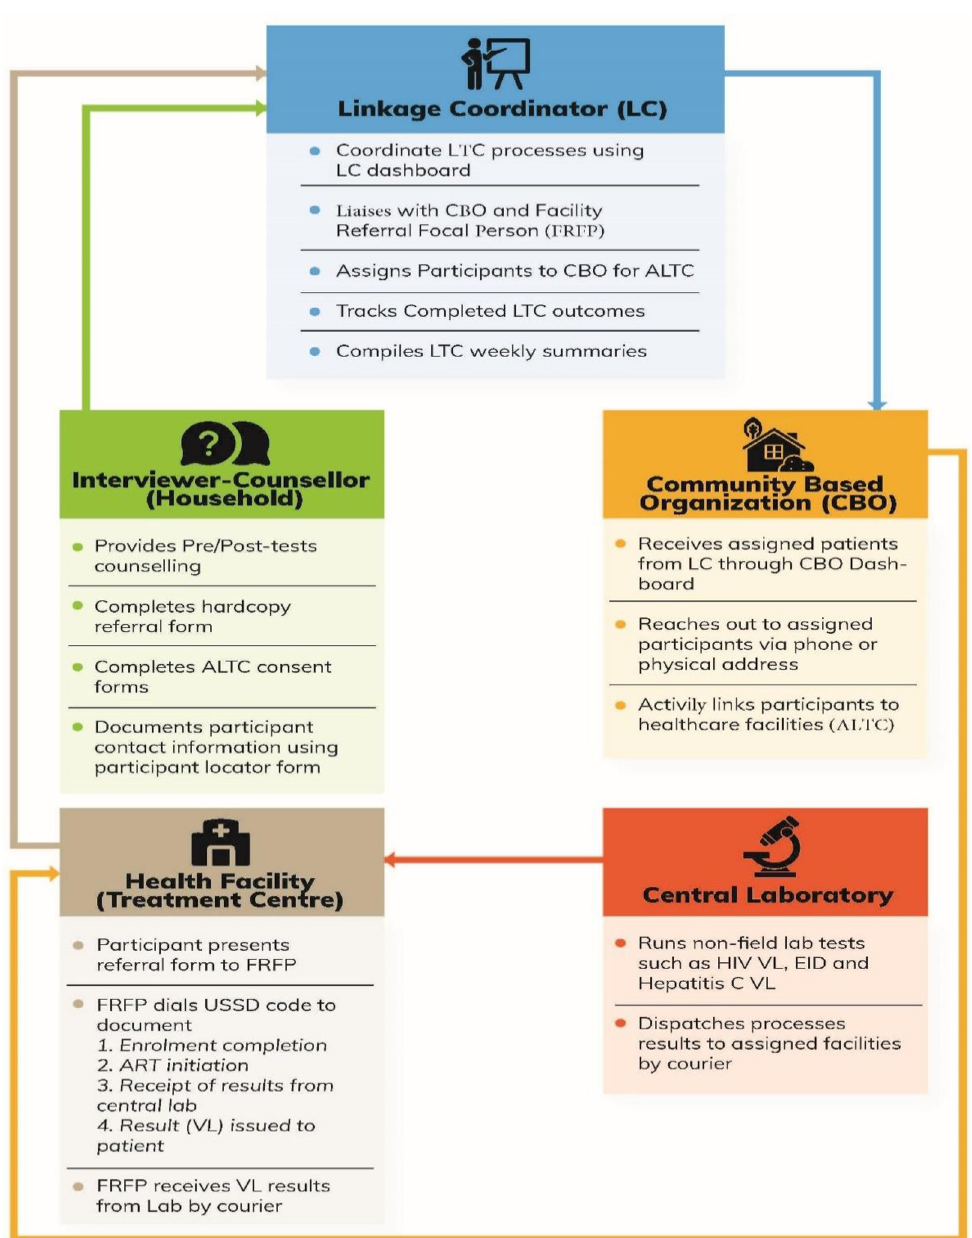
Fig 1. Active linkage to care processes, NAIIS 2018. Abbreviations: LC–Linkage Coordinator; LTC–Linkage to Care; CBO–Community Based Organization; ALTC–Active Linkage to Care; FRFP–Facility Referral Focal Person; USSD– Unstructured Supplementary Service Data; VL–Viral Load; EID–Early Infant